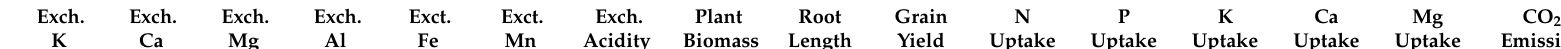
Table 9. The correlation coefficient among maize plant parameters, nutrients uptake, soil pH, and nutrients (all relations were significant).